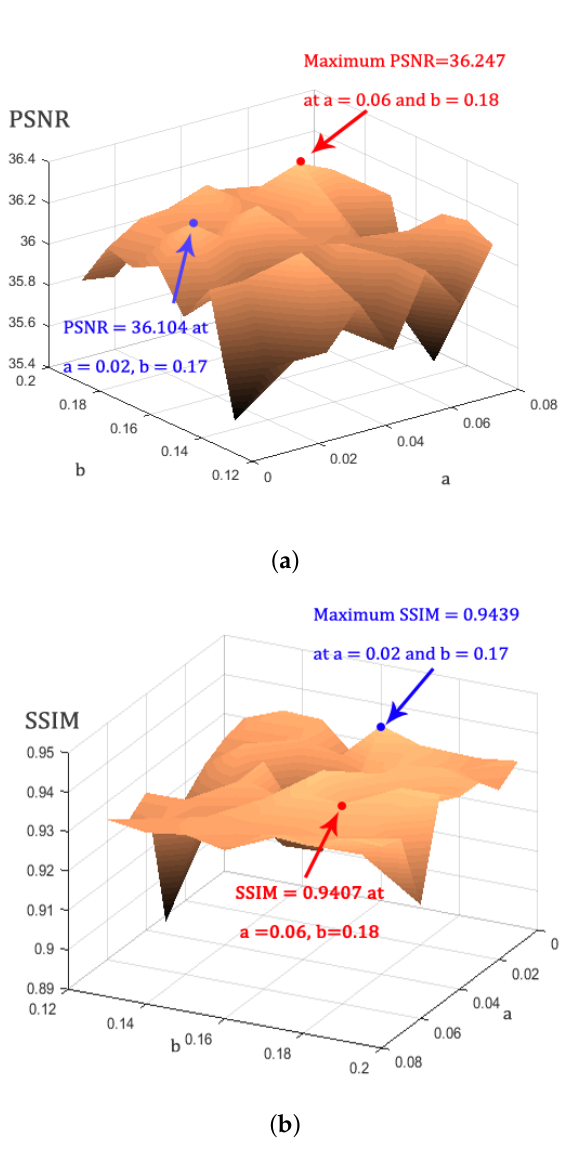
Figure 5. Summary of the tests performed to numerically establish the best values for the parameters a and b for controlling the similarity between the signals according to the magnitude of the reference signal and the estimated level of noise. ( a ) PSNR surface where each point corresponds to the average PSNR of the MR phantom images corruped with different Rician noise levels and denoised using the two first stages of our method. ( b ) SSIM surface obtained similarly to the PSNR